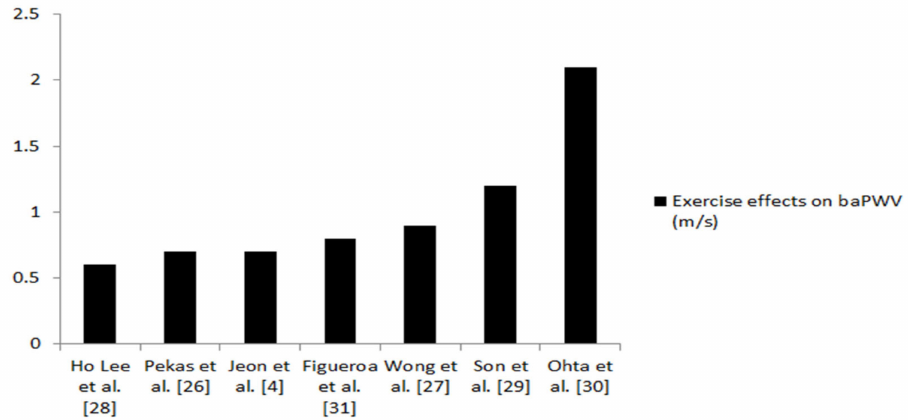
Figure 2. Effects of combined training on arterial stiffness